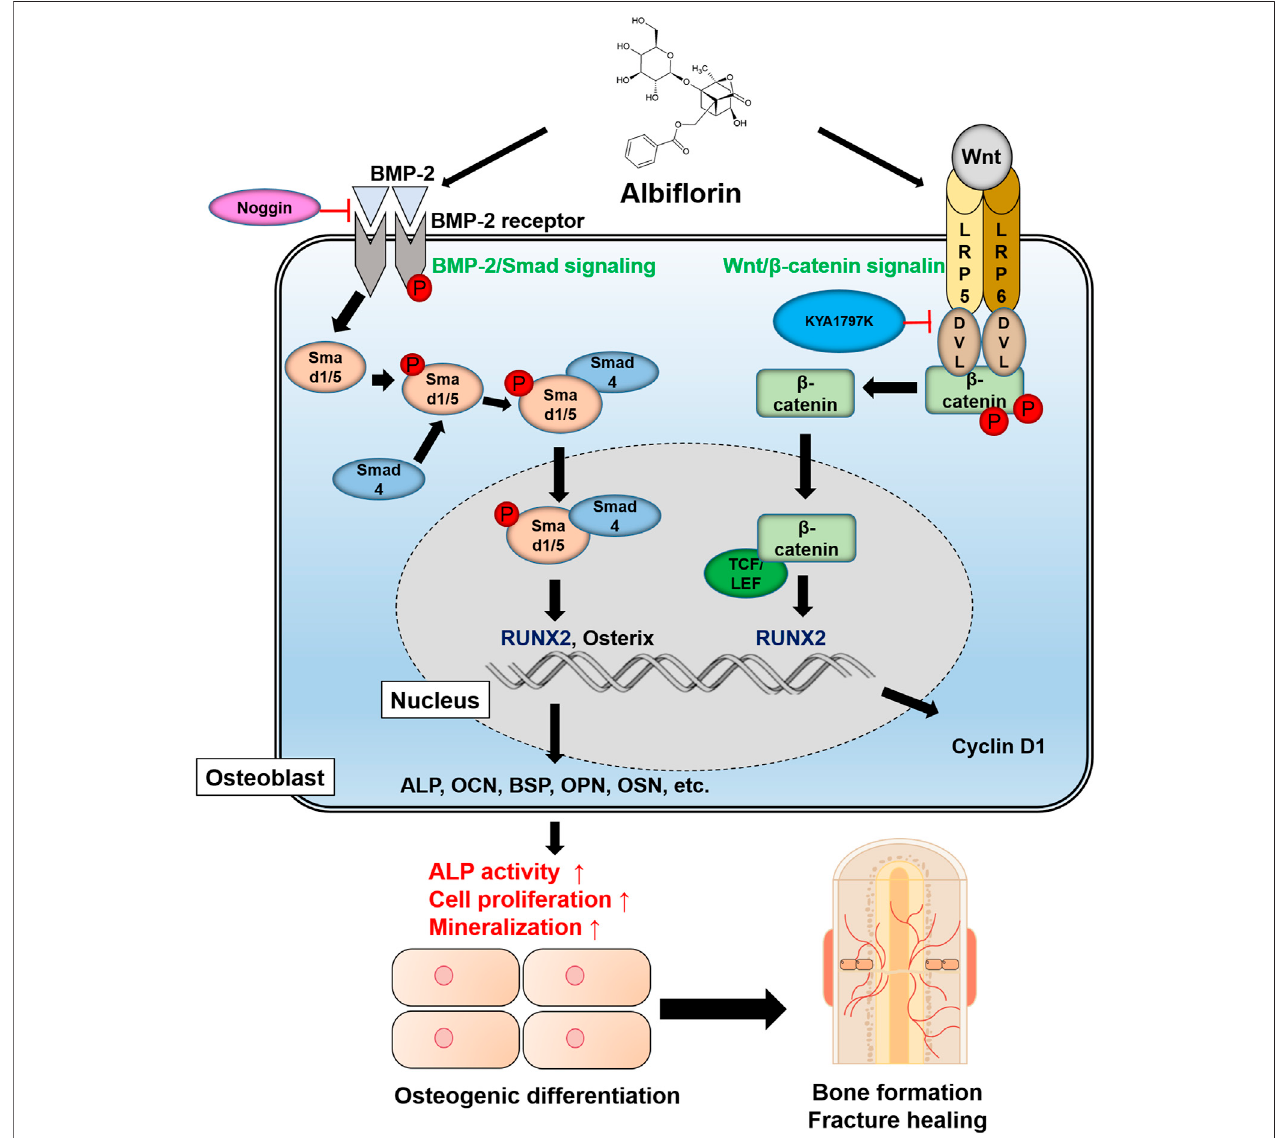
FIGURE8| Schematicdiagram ofalbi fl orinpromotingosteoblastdifferentiation. Albi fl orin stimulates BMP/Smad signaling andWnt/ β -catenin signaling topromote osteoblast differentiation and bone formation.